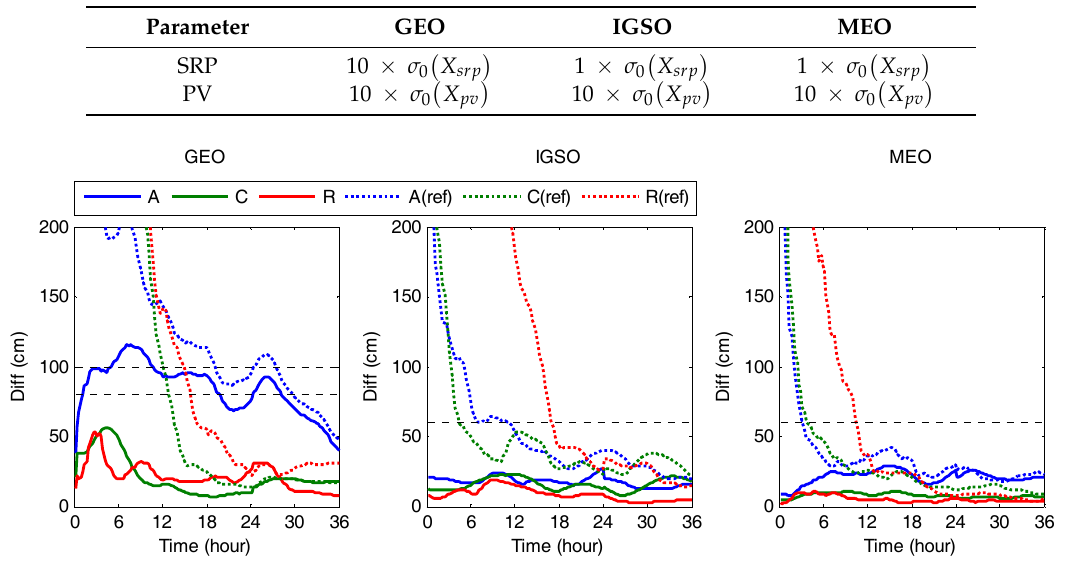
Figure 6. Time series of the average the accuracy of the filter orbits with the optimal a prior STD magnitude. The UR product is used as the initial orbit and the latency time is 3 h. The dotted line represents the accuracy of the REF orbits described in Section 3.1. The horizontal black dotted line represents the convergence criteria for each direction.